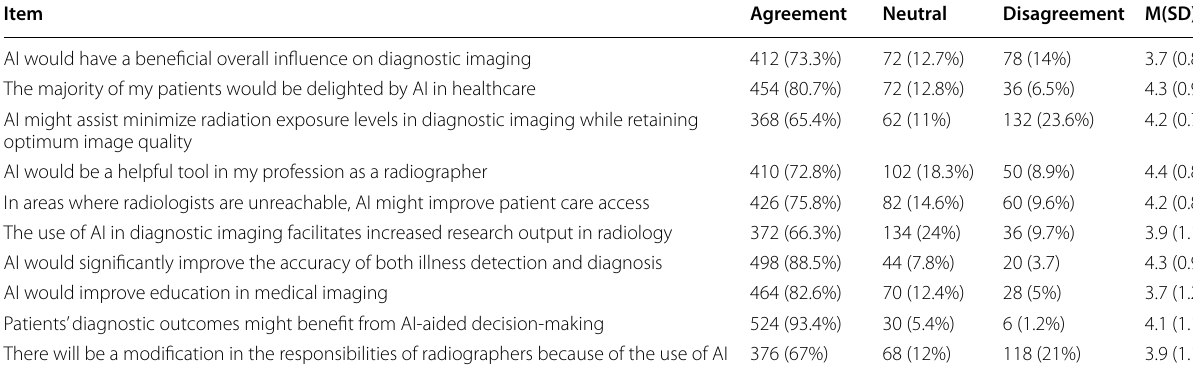
Table 3 Respondents’ thoughts on the potential positive effects of AI in diagnostic imaging